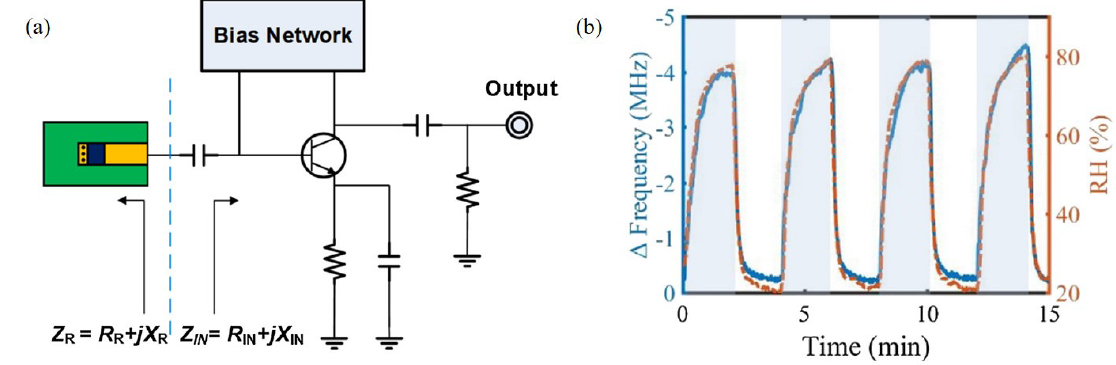
Figure 13. Characterization of the oscillator-based relative humidity sensor with PEDOT:PSS. ( a ) Schematic of the sensor. ( b ) Variation in oscillating frequency with change in relative humidity [94].